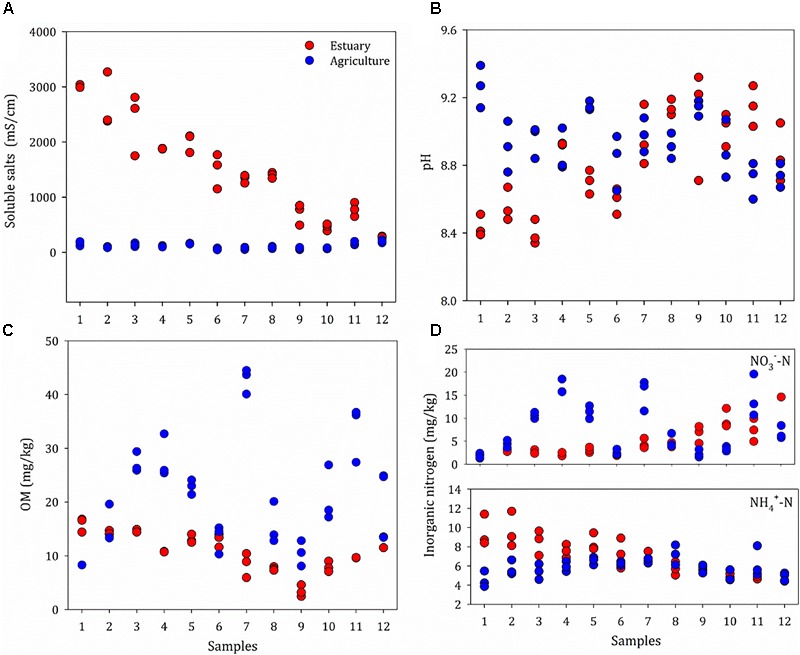
Properties of soils at the mudflat (Estuary) and agricultural (Agriculture) sites, including Soluble salts (A), pH (B), OM (C) and Inorganic nitrogen (D). Original values are given in Supplementary Table S1. OM, organic matter.